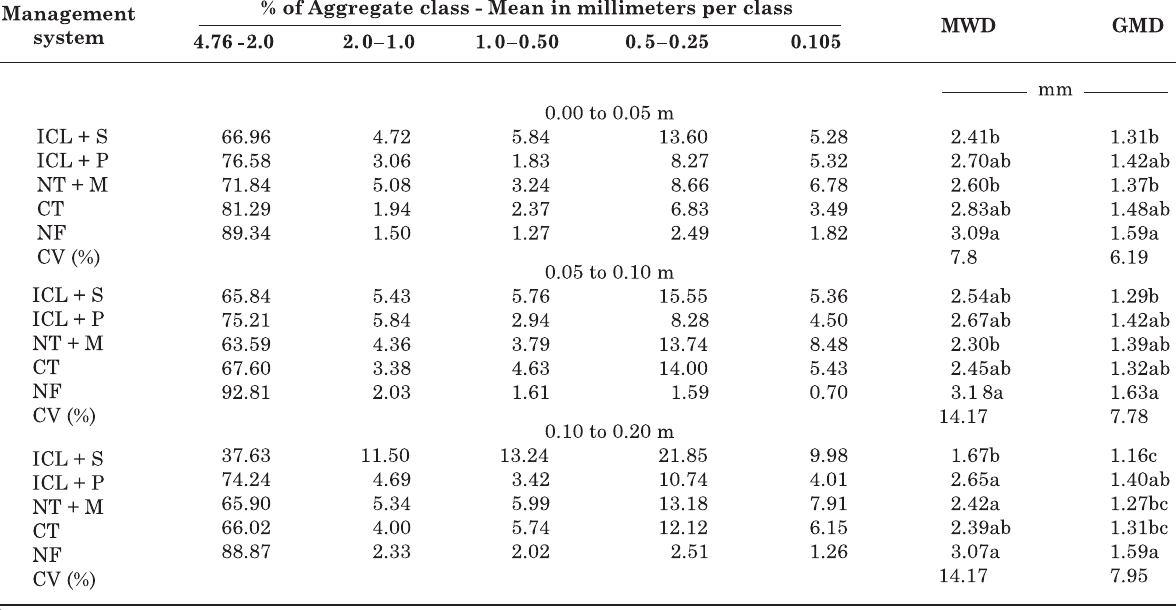
Table 3. Mean Weight Diameter (MWD) and Geometric Mean Diameter (GMD) of Yellow Latosol at